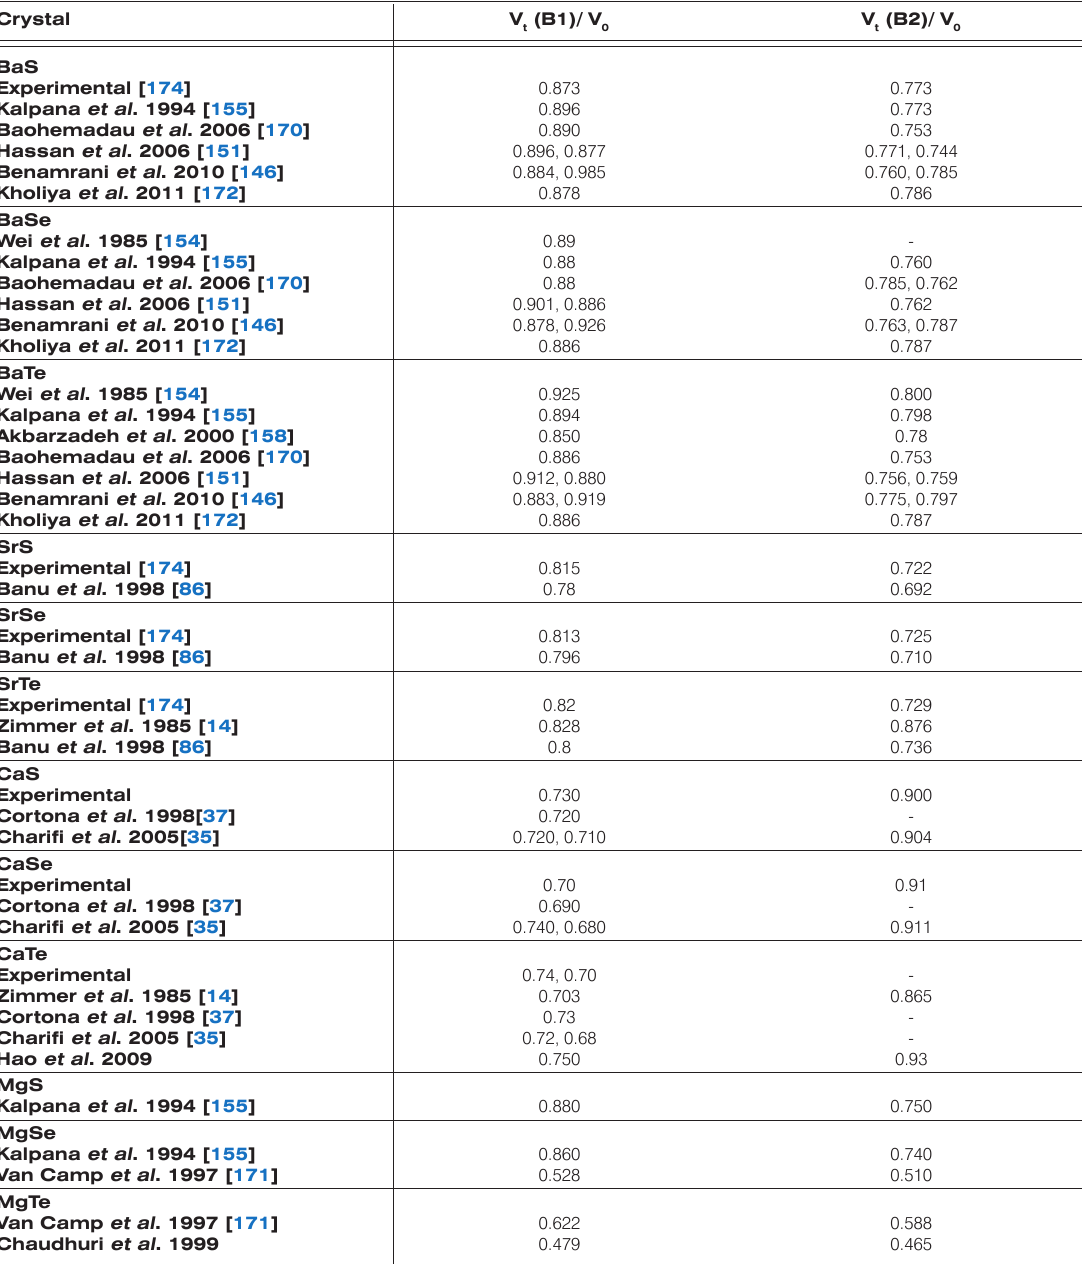
summarized in Table 3. Different theoretical values